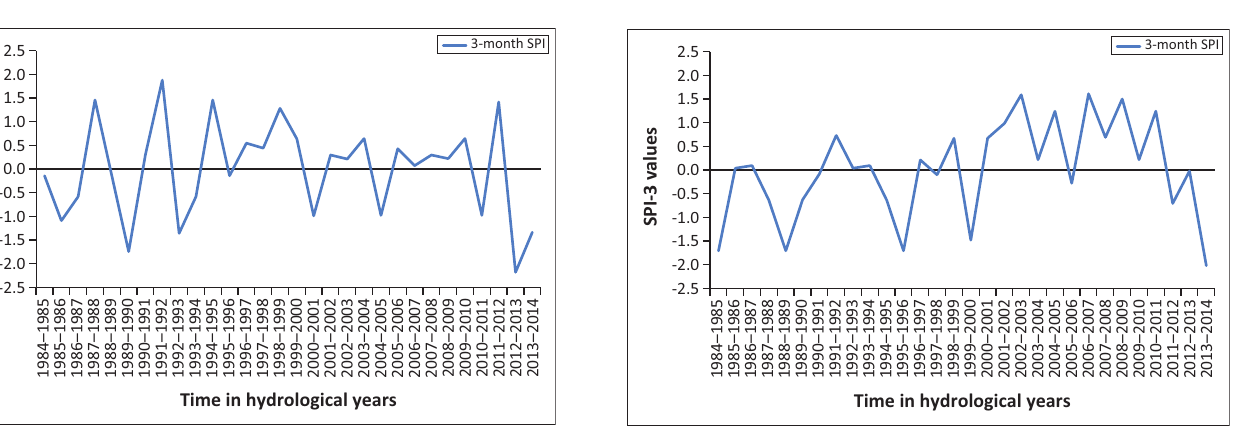
FIGURE 1: Study area, Mafeteng district in Lesotho. (a) Mafeteng district and (b) Lesotho.